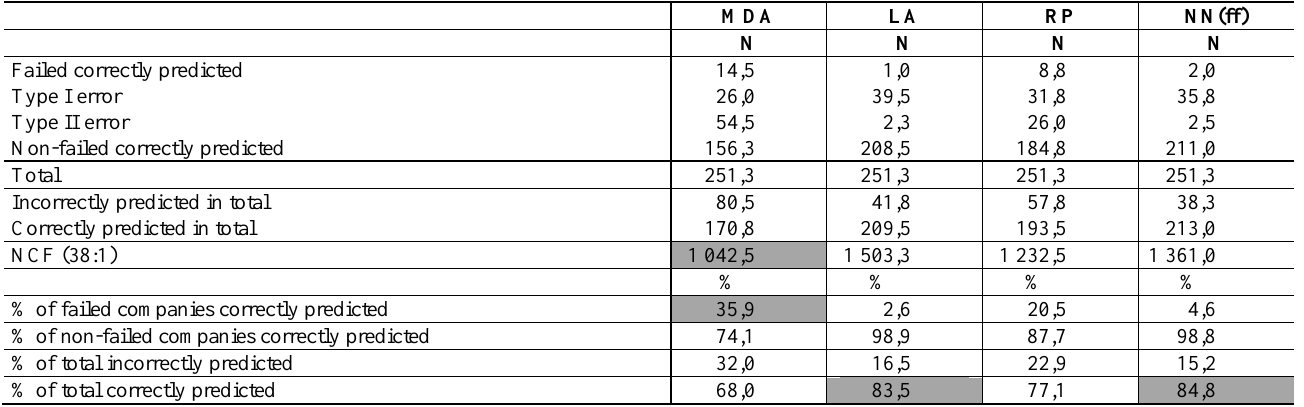
Table 3: Average predictive accuracy for each different technique